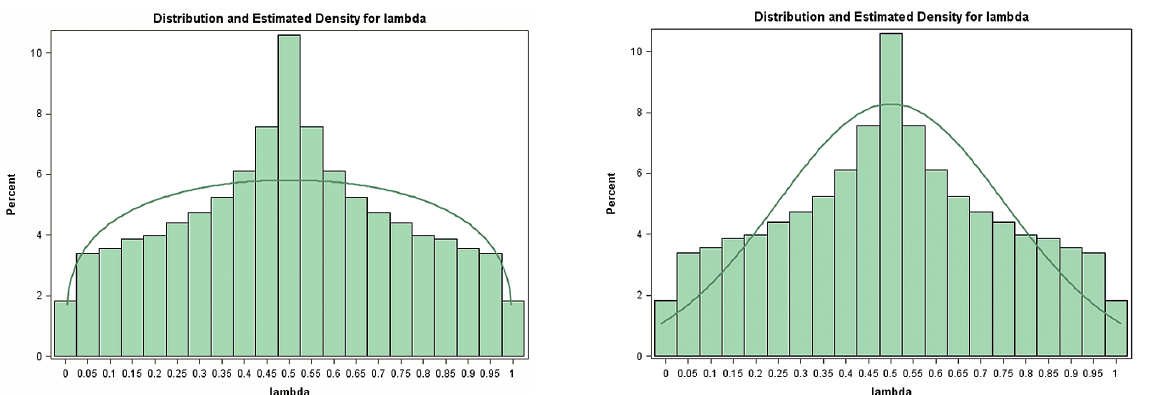
Fig. 8. Approximations to the frequency distribution of the eigenvalues for a regular square tessellation; n = 3,888 Left (a): beta approximation (Kolmogorov-Smirnov = 0.04662). Right (b): normal approximation (Kolmogorov-Smirnov =